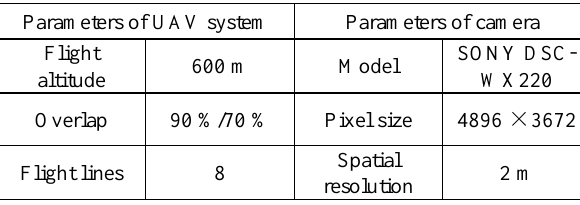
Table 1.Specific parameters